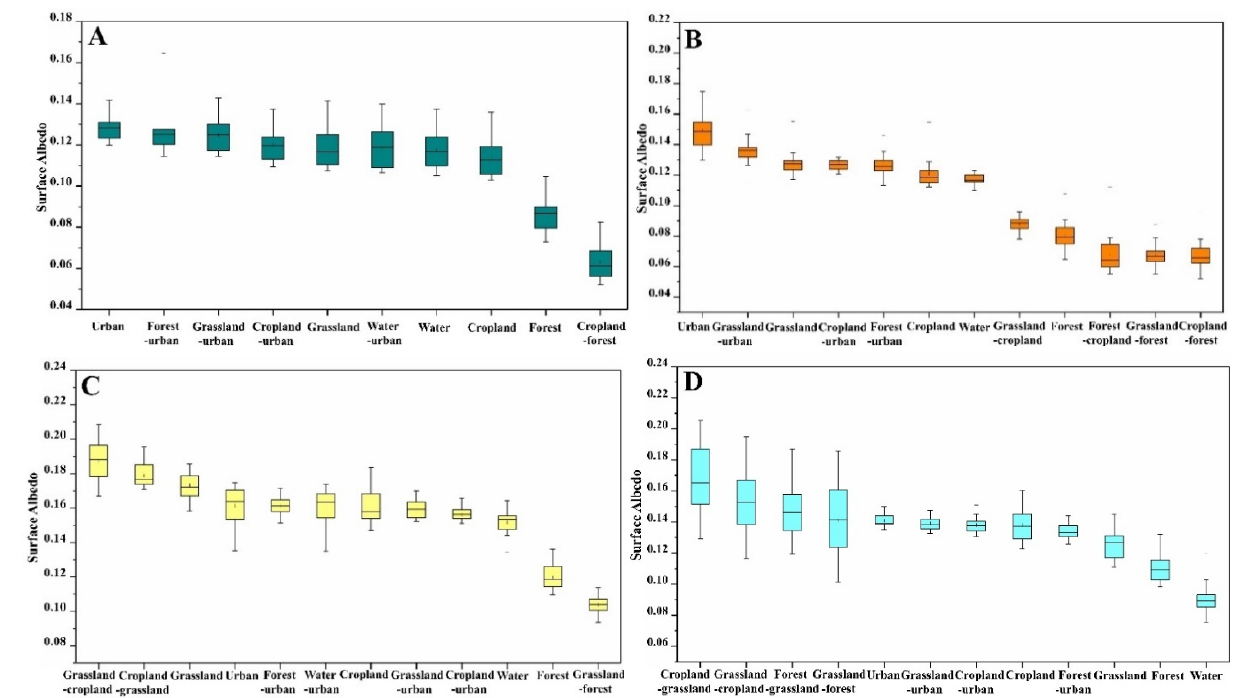
Figure 7. Statistical characteristic values of surface albedo based on different land types from 2000 to 2015 (( A ) Jinan City, ( B ) Zhengzhou City, ( C ) Lanzhou City, ( D ) Xining City).